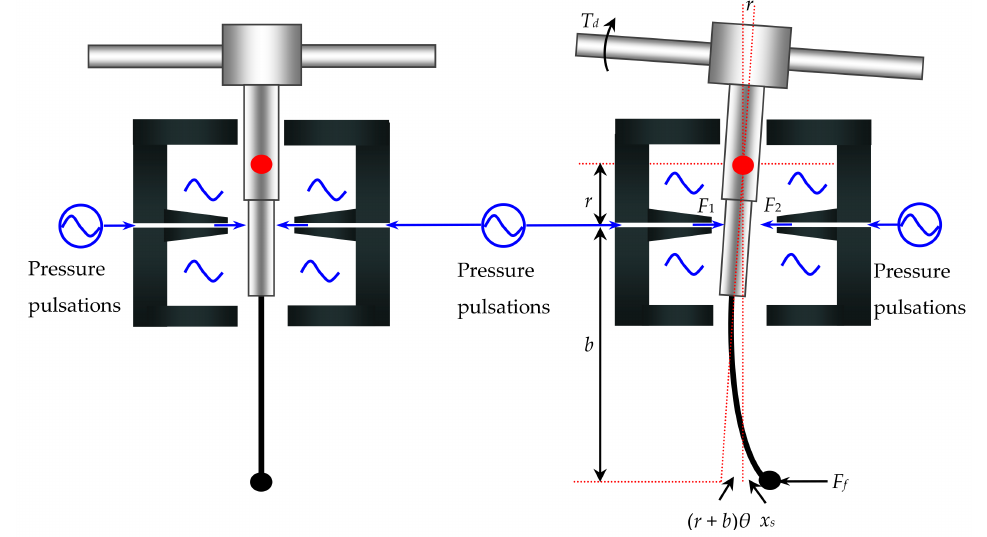
Figure 2. Angular movement of the flapper-armature